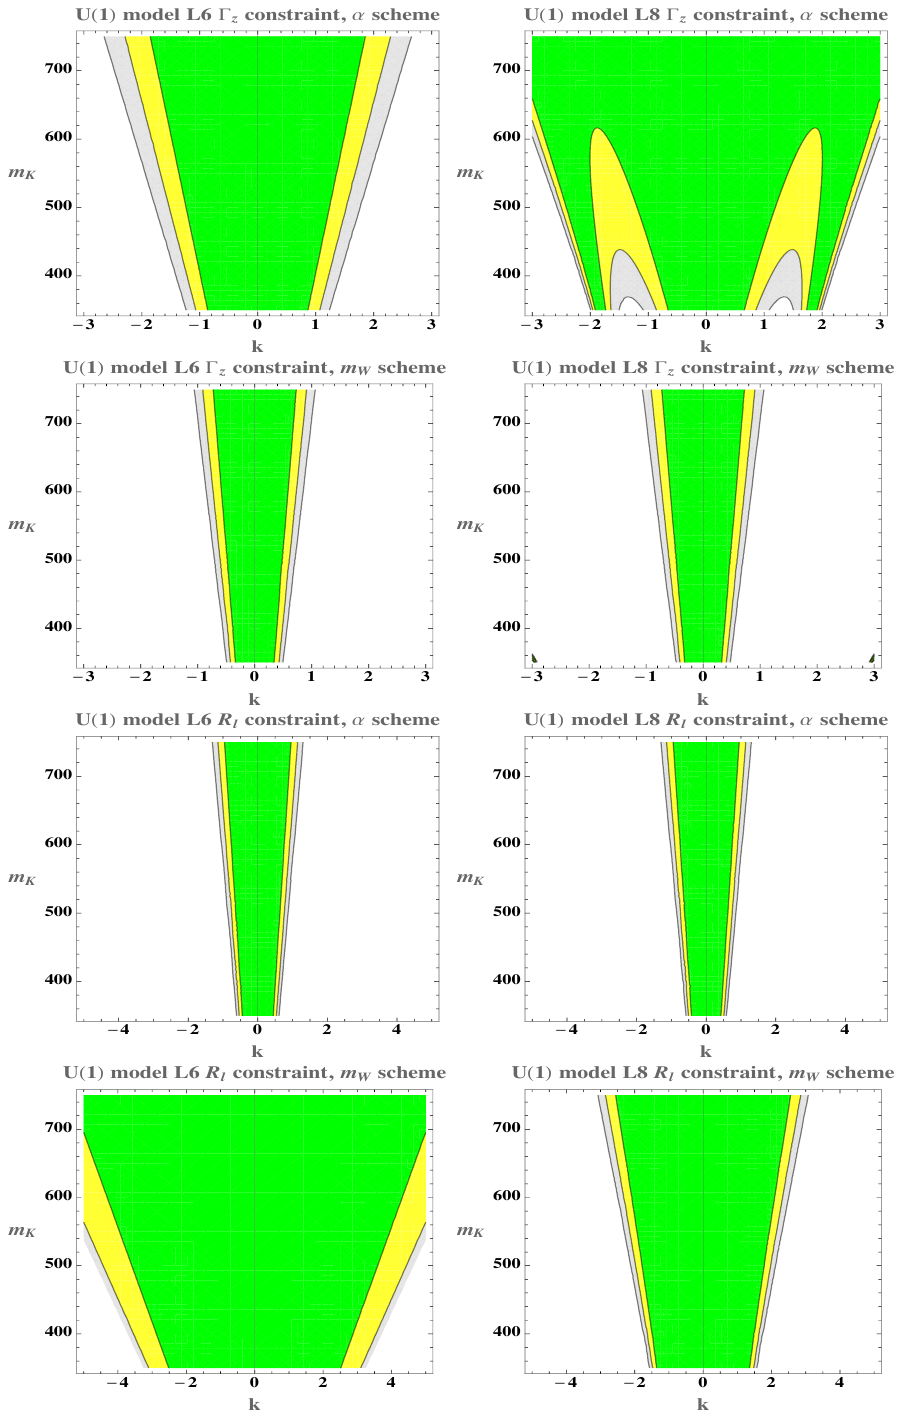
Figure 4 . Constraints from EWPD observables in the U(1) mixing model. The results are organised so that increasing the precision of the theoretical predication from O ( v 2 / Λ 2 ) to O ( v 4 / Λ 4 ) from left to right. Both the α and m W schemes results are shown, and individual observables carry a significant scheme dependence. Shown are the constraints on the model space from the Γ Z and R ‘